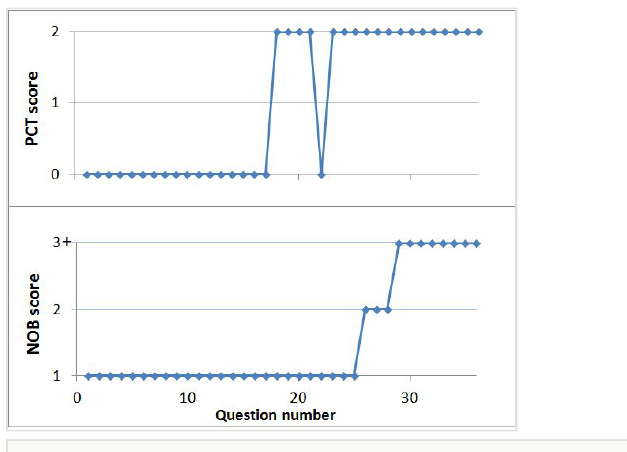
Figure 12. Graphical representation of neurobiological requirements for questions WISC-V, Figure Weights. The NOB score (bottom) and the PCT score (top) as a function of question number.